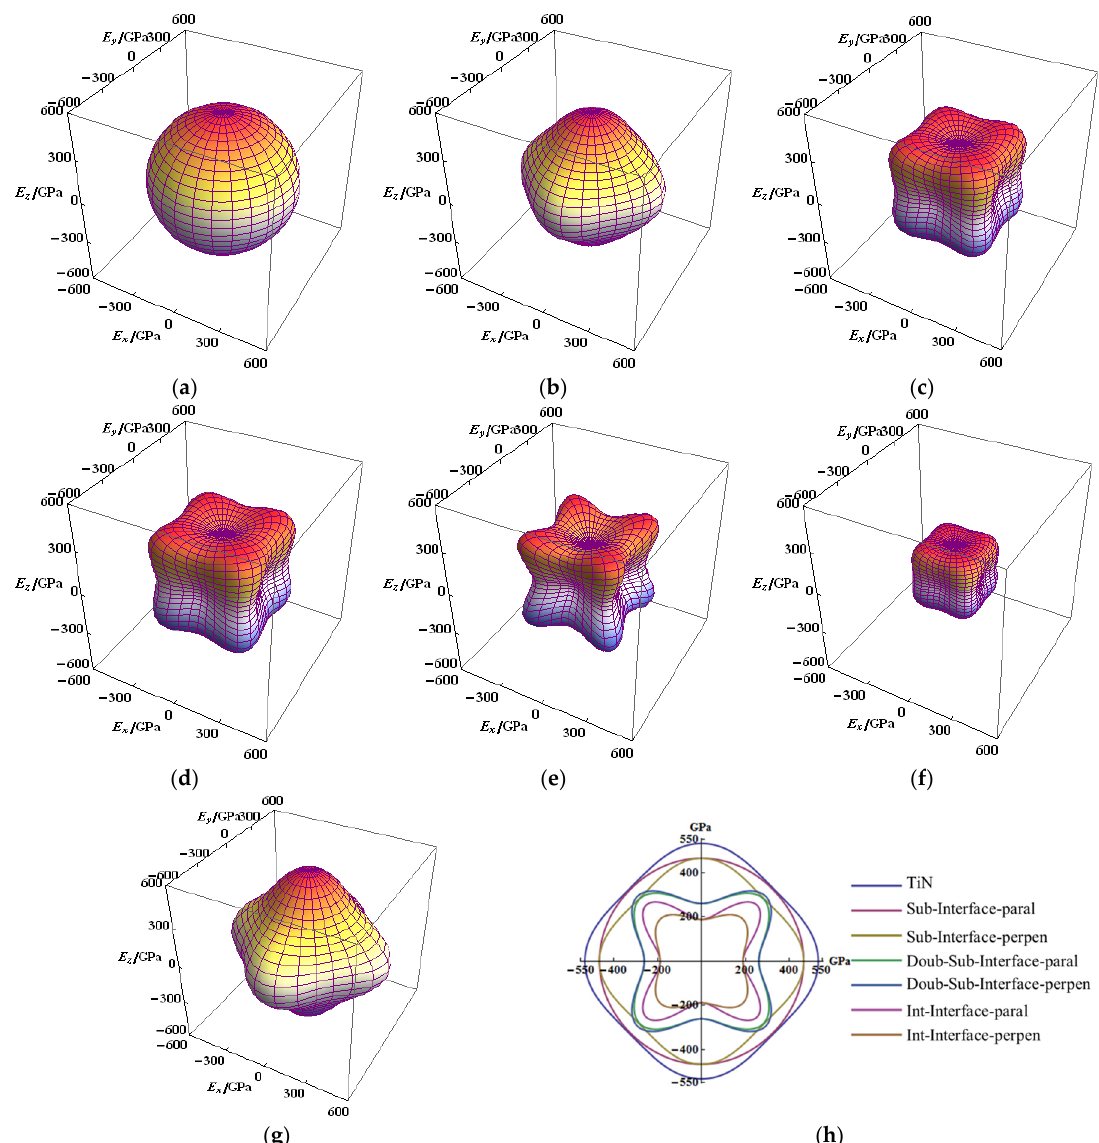
Figure 3. Directional dependence of the Young’s moduli for interfaces of Ti–Si–N, cross ‐ sections (in the x ‐ y plane) of the Young’s moduli surfaces for TiN and interfaces: ( a ) parallel to the substitution interface (1Si–6N); ( b ) perpendicular to the substitution interface; ( c ) perpendicular to the double ‐ substitution interface; ( d ) parallel to double ‐ substitution interface; ( e ) parallel to the interstitial interface (1Si–4Ti4N); ( f ) perpendicular to the interstitial interface (1Si–4Ti4N); ( g ) the TiN crystal; and ( h ) cross ‐ sections (in the x ‐ y plane) of the Young’s moduli surfaces for TiN and interfaces.